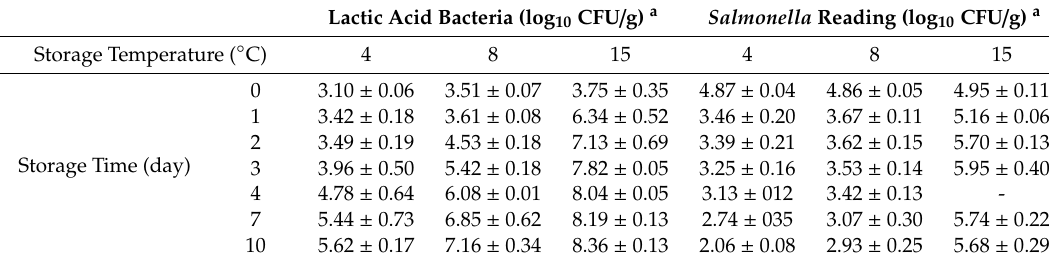
Table 1. Experimental data of lactic acid bacteria and Salmonella Reading on fresh iceberg lettuce stored at di ff erent temperatures for up to 10 days. Lactic Acid Bacteria (log 10 CFU / g) a Salmonella Reading (log 10 CFU / g) a Storage Temperature ( ◦ C)